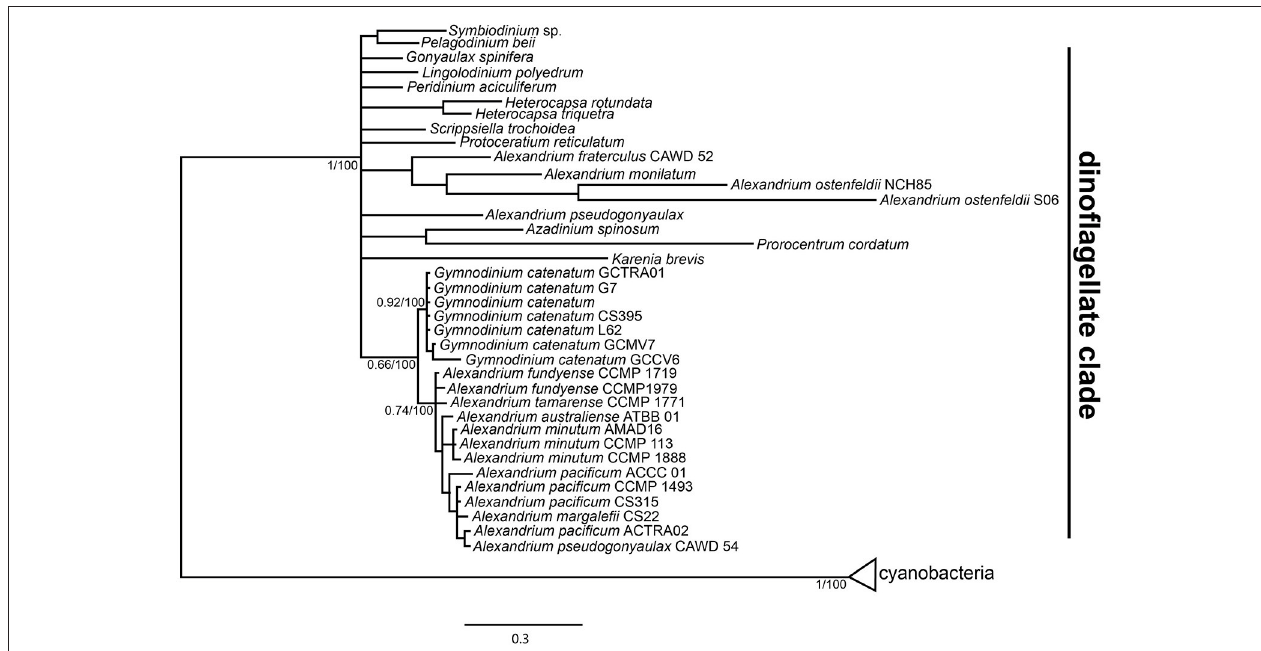
FIGURE 2 | Phylogenetic tree of the domain sxtA1 from amino acids sequences of dinoflagellates and cyanobacteria. The tree is reconstructed with Bayesian Inference, the numbers in the internal nodes represent the posterior probabilities/boostrap values.